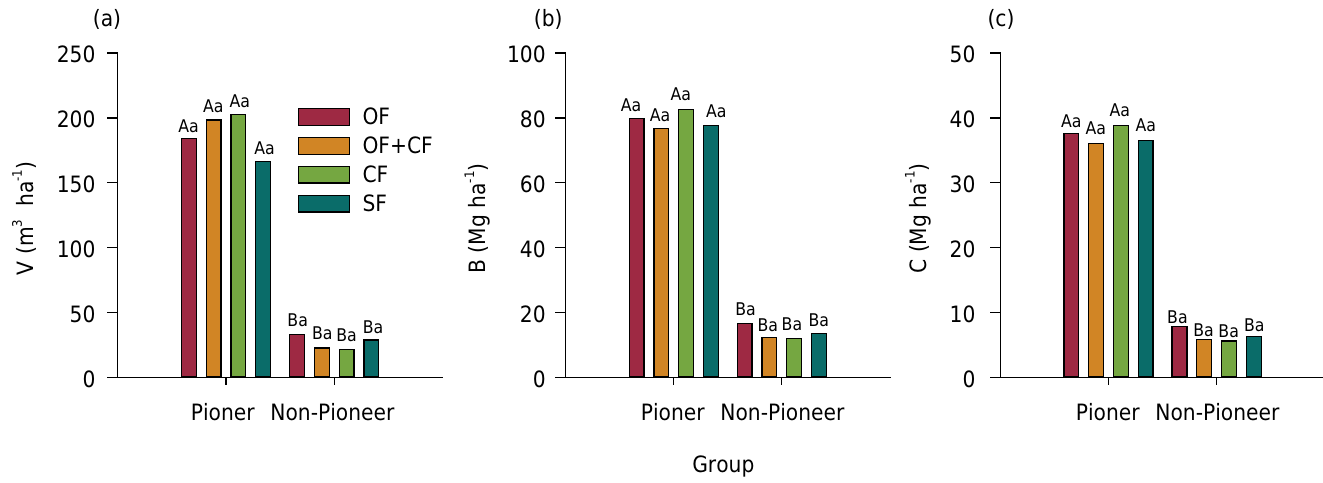
Figure 6. Volume (v; a), biomass (b), and carbon stocks (c) in native pioneer forest species and native non-pioneer forest species at 56 months of age, planted in area of bauxite mining and submitted to standard (sf), combined organic and chemical (of+cf), organic (of), and chemical (cf) fertilizers. Uppercase letters compare the mean values for the groups (pioneers and non-pioneers) within the same fertilizer, while lowercase letters compare the fertilization treatments within the same group and, when equal, indicate the lack of significant difference between them by Tukey’s test at 10 % probability